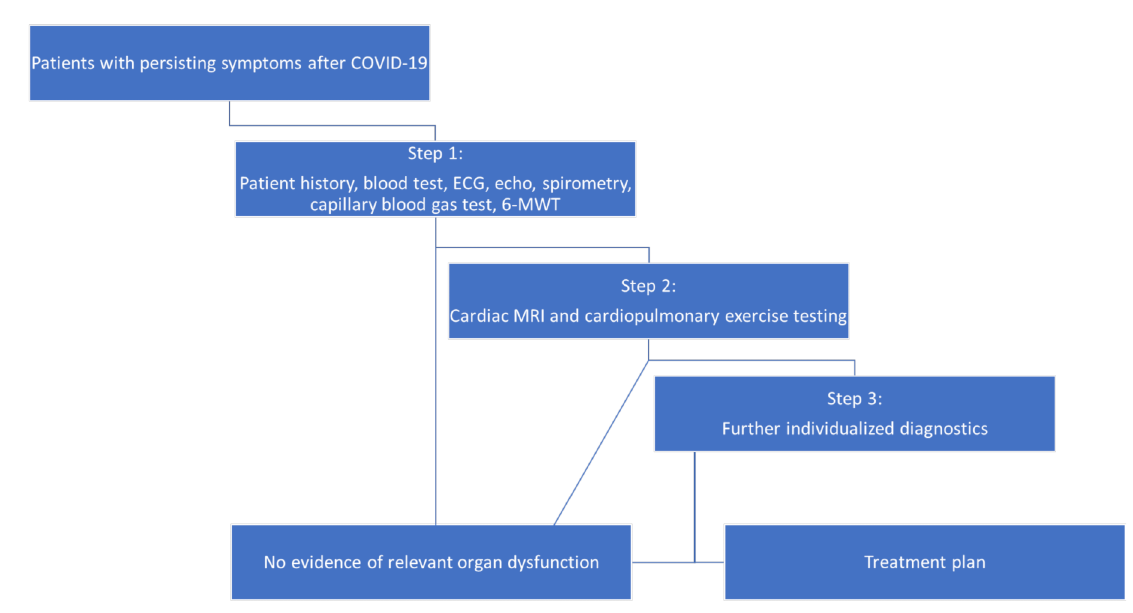
Figure 1. Stepwise diagnostic workup of patients with long COVID syndrome. ECG, electrocardiogram; MRI, magnetic resonance imaging; 6-MWT, 6-min walk